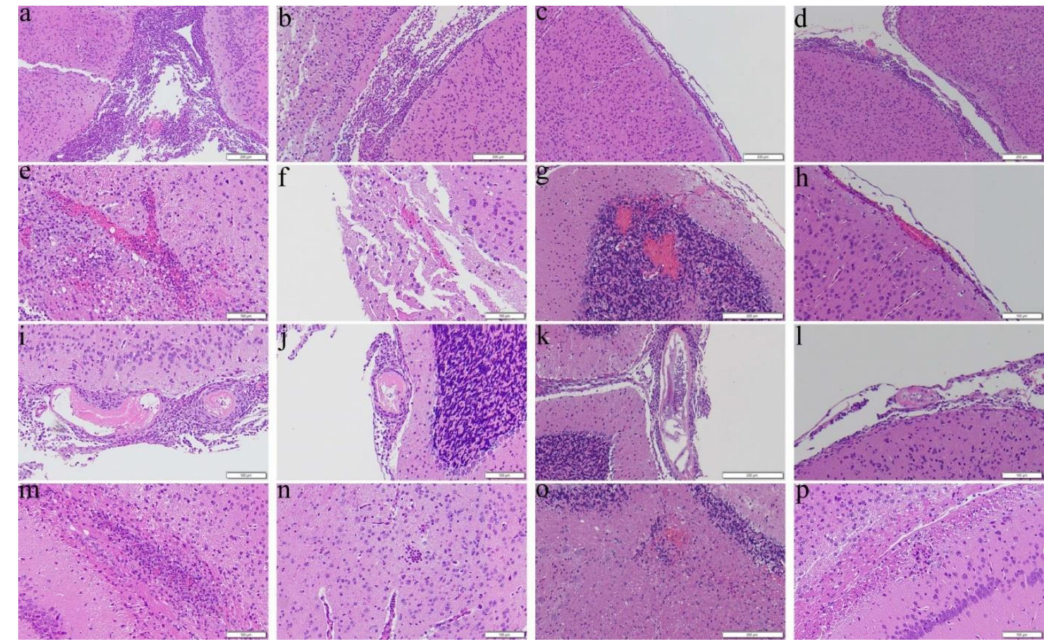
Figure 8. Representative photomicrographs showing meningitis, size of worms, hemorrhage, and encephalitis in the cerebral parenchyma of the C57BL/6 mice infected with Angiostrongylus cantonensis treated from day 14 for 14 days. ( a , e , i , m ) Untreated mice. ( b , f , j , n ) Mice treated with albendazole alone. ( c , g , k , o ) Mice treated with dexamethasone alone. ( d , h , l , p ) Co-therapy of albendazole and